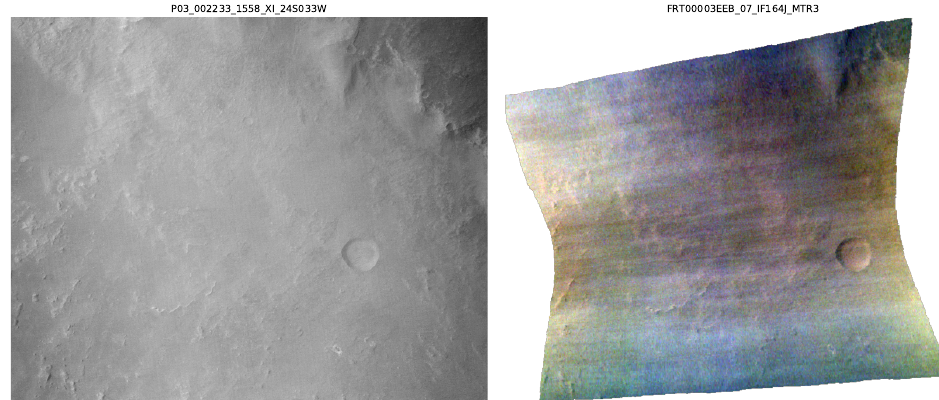
Figure 6. Example of CRISM observation deemed too noisy for training ( right ) next to corresponding CTX cut-out ( left